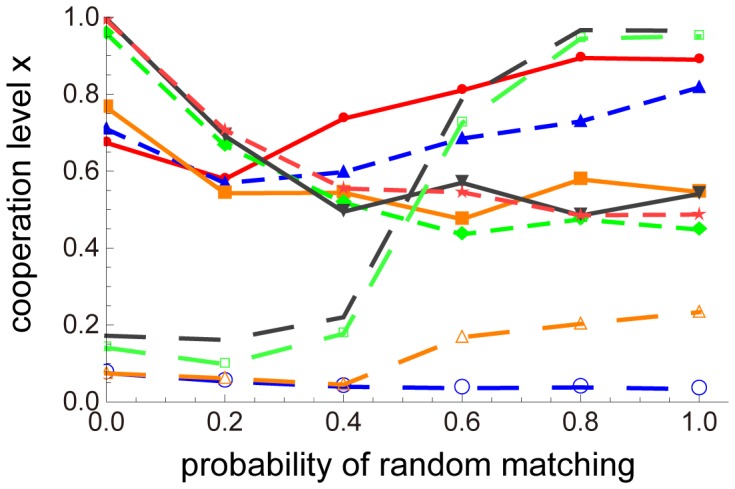
Effect of randomness on evolution of cooperation level when a is fixed.The horizontal and vertical axes represent randomness (p) and the value of the cooperation level (x), respectively, after 1,000,000 generations. The dotted blue line with open points is the average x of 50 trials of a = 0.0; the orange dotted line with open triangles, a = 0.01; the green dotted line with open squares, a = 0.07; the black dotted line, a = 0.1; the solid red line with points, a = 1; the dotted blue line with triangles, a = 2; the orange solid line with squares, a = 5; the green dotted line with diamonds, a = 20; the black solid line with inverted triangles, a = 100; and the red dotted line with stars, a = 1,000. Other parameters are the same as in Fig. 3.